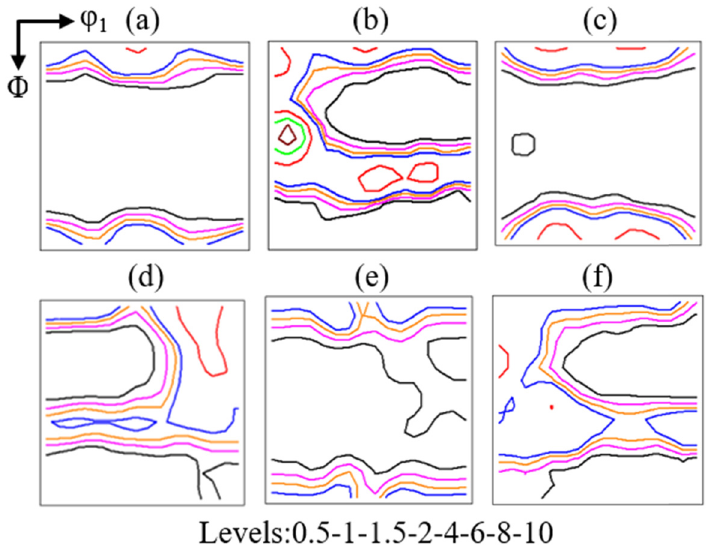
Figure 9: ODF diagram of di ff erent cold - rolling deformation of grain - oriented silicon steel: ( a ) 72% Y - bearing φ 2 = 0°; ( b ) 72% Y - bearing φ 2 = 45°; ( c ) 60% Y - free φ 2 = 0°; ( d ) 60% Y - free φ 2 = 45°; ( e ) 60% Y - bearing φ 2 = 0°; ( f ) 60% Y - bearing φ 2 = 45°.